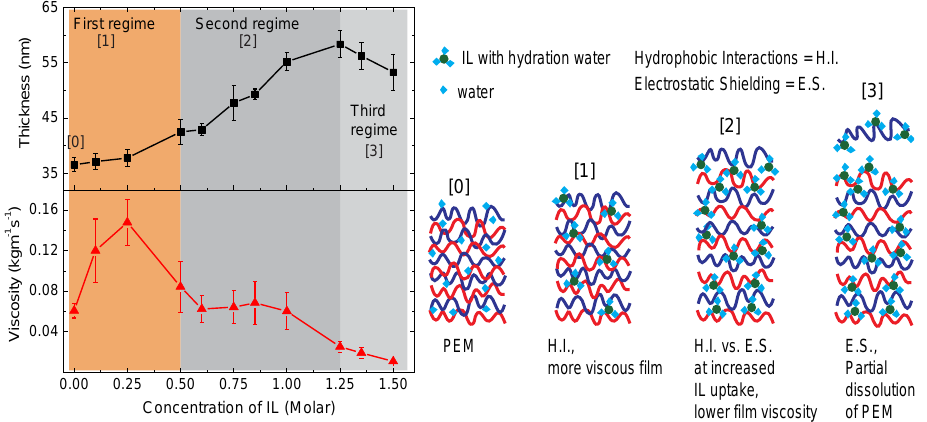
Figure 6. Modeled thickness and viscosity of a multilayer upon swelling with aqueous solutions of an IL. Different concentration regimes of the IL are highlighted, and schemes (0 to 3) illustrate the effect of hydrophobic interactions and electrostatic shielding on the film thickness, viscosity and/or elasticity of a multilayer swollen with IL solutions over the different concentration regimes.